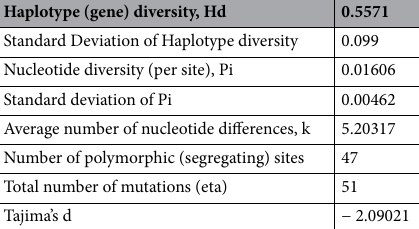
Table 5. Haplotype diversity and Tajma